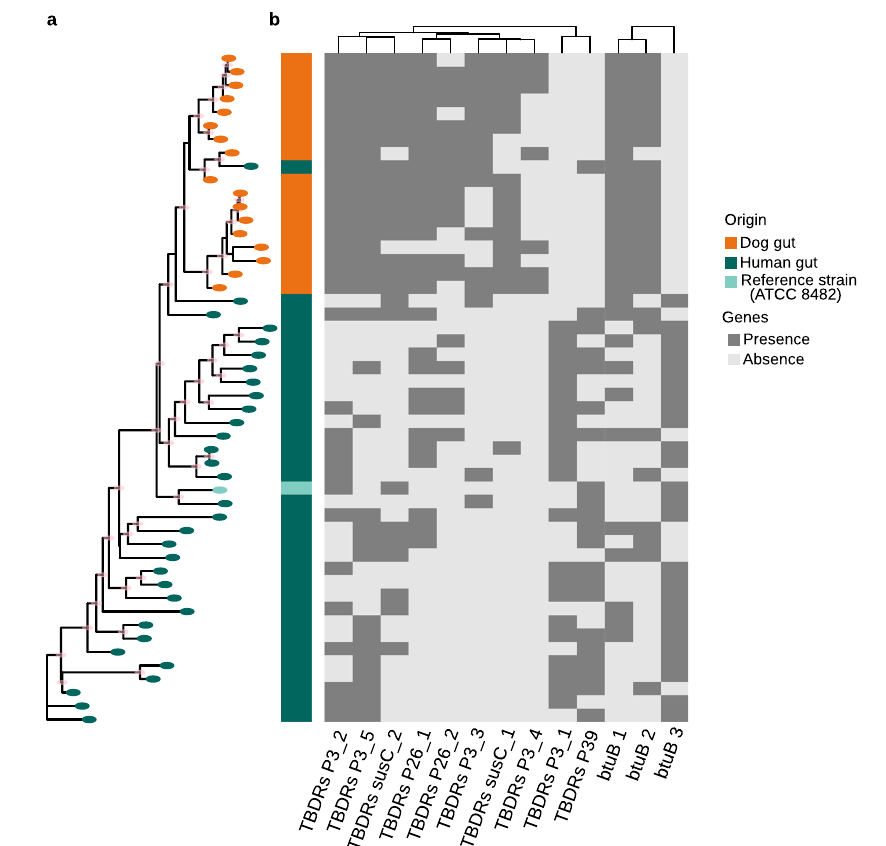
Fig. 6 Strains of B. vulgatus recovered from the human and dog gut microbiomes and the type strain B. vulgatus ATCC 8482 cluster according to their host. a Shown is the maximum-likelihood phylogenetic tree based on core genes; branches with bootstrap values higher than 70 were marked pink in the nodes. Clustering based on ANI or gene presence also showed a separation between the hosts (see Supplementary Fig. 17). b The gene content of the strains was also statistically different between the two hosts ( P < 0.05, n = 50, using Fisher ’ s exact test after FDR correction using the Benjamini – Hochberg method, see Methods). In particular, the presence of different TonB-dependent receptors (TBDR) and their interaction partner btuB , which are involved in nutrient uptake, differs (see Supplementary Text). Source data are provided as a Source Data fi